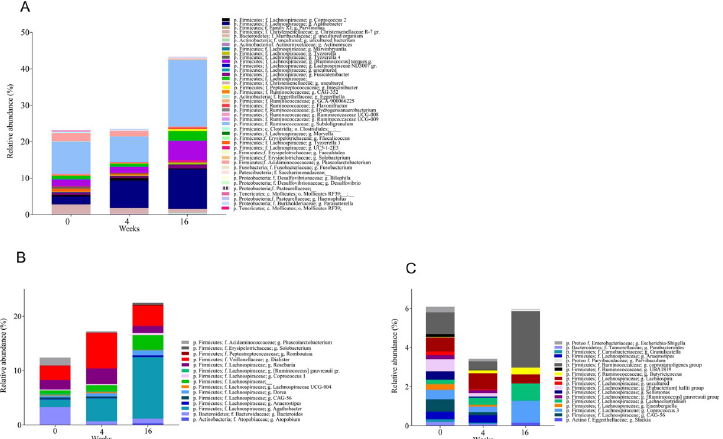
Fig 4. Relative abundance of total, IgA and IgM coated fecal bacteria in the FMT group. Genera that showed increased relative abundance after FMT were predominantly within the Firmicutes phylum, including genera within the Ruminococcaceae and Lachnospiraceae families. At baseline, relative abundance of IgA and IgM coated fecal bacteria were similar in the FMT and placebo groups. IgA and IgM coating pattern at genera level changed from baseline to weeks 4 and 16 in the FMT group, while the placebo group showed stable relative abundances of these genera. A: Relative abundance of unsorted bacteria. Only bacteria with change (p < 0.1) in relative abundance of unsorted bacteria from week 0–4 or week 0–16 are shown. B: Relative abundance of IgA coated bacteria. Only bacteria with changes (p < 0.1) in relative abundance of IgA coating from week 0–4 or week 0–16 are shown. C: Relative abundance of IgM coated bacteria. Only bacteria with change (p < 0.1) in relative abundance of IgM coating from week 0–4 or week 0–16 are